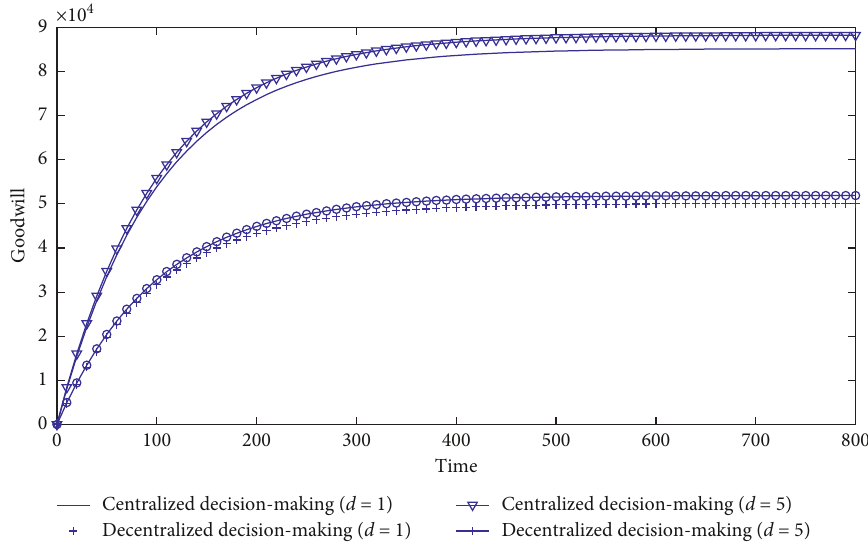
Figure 1: Comparison of brand goodwill under decentralized and centralized